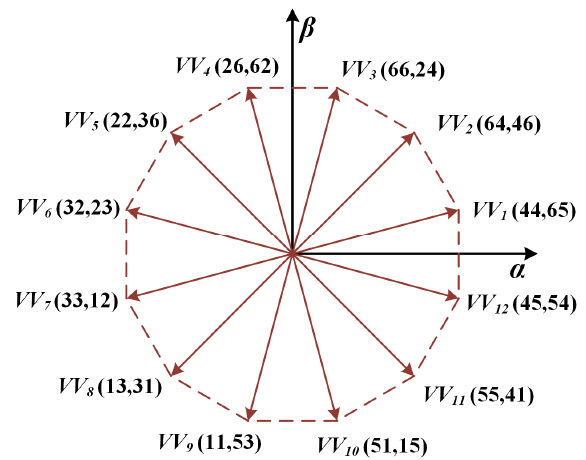
Figure 3. Virtual voltage vectors in the α - β subspace.